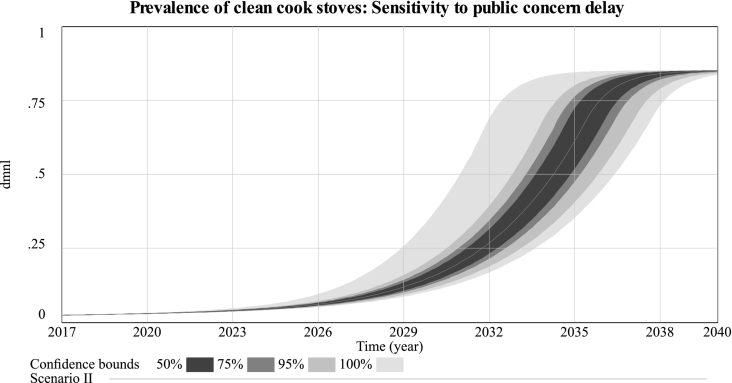
Sensitivity of prevalence of clean cook stoves to public concern delay.